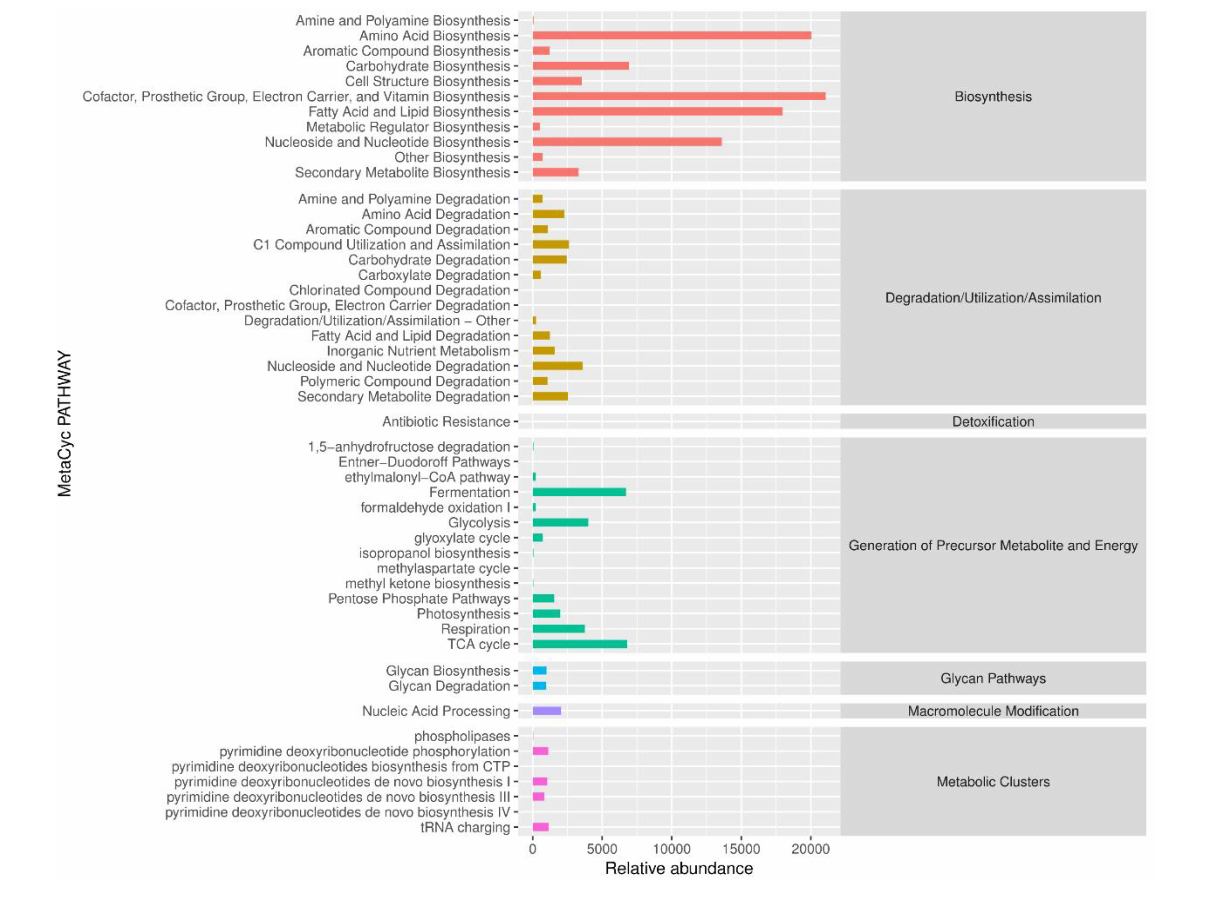
FIGURE 7 | KEGG metabolic pathway abundance